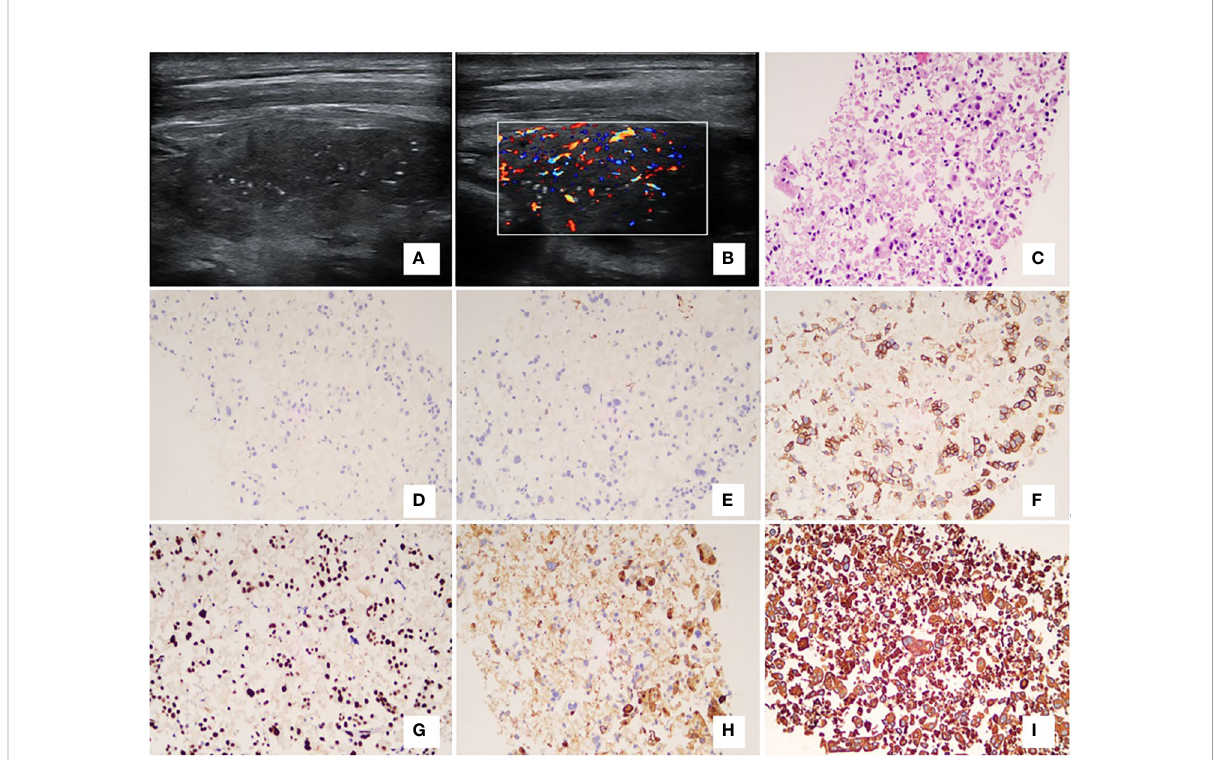
FIGURE 3 Case12, a 68-year-old female patient had a 7-year history of malignant breast tumor. Ultrasonography showed an irregular and hypoechoic nodule with micro-calci fi cations (A) . On color Doppler, it showed intra-nodular high vascularization (B) . The patient underwent fi ne-needle aspiration cytology. The cell mass exhibited scattered malignant tumor cells with necrosis, large hyperchromatic nuclei, and irregular nuclear membranes [ (C) – 200x]. In immunohistochemistry, the malignant cells showed negative expressions of estrogen receptor [ (D) – 200x] and progesterone receptor [ (E) – 200x], and positive for HER2 ( F – 200x), GATA-3 [ (G) – 200x], GALACTIN-3 ( H – 200x), and AE1/AE3 ( (I) – 200x). (A, B) ultrasonography; (C) hematoxylin-eosin staining; (D – I)